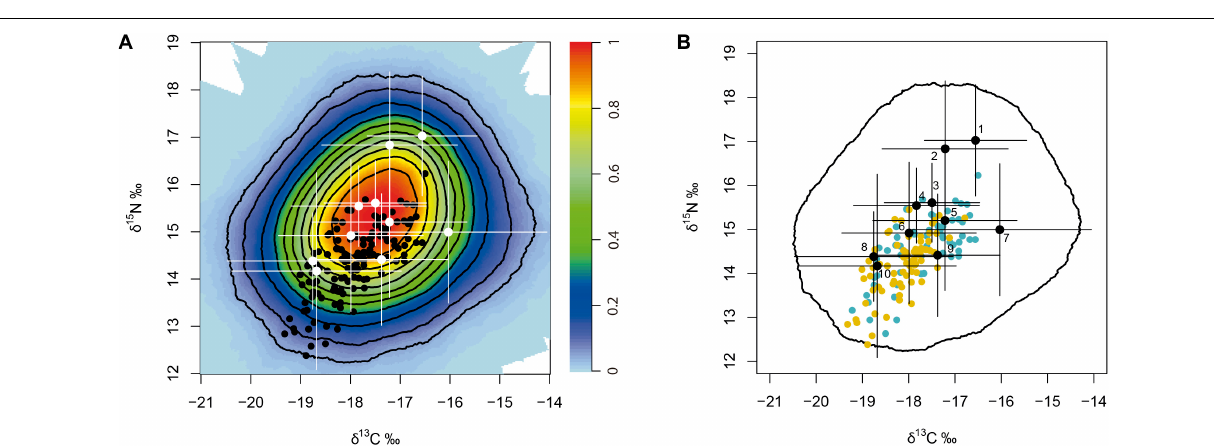
FIGURE 2 | MixPolygon results. (A) Gannets’ isotopic data (black dots) and the potential prey (white dots and bars; mean ± SD). The colour background displays the probability that a consumer’s isotopic signature is explained by the proposed mixing model. Probability contours are printed every 10%. Prey species included are detailed in Table 1 . (B) Gannet data coloured by sex: orange, females; blue, males. Prey data numbered: 1, Trisopterus esmarkii ; 2, Merlangius merlangus ; 3, Merluccius merluccius ; 4, Ammodytes spp.; 5, Chelidonichthys cuculus ; 6, Clupea harengus ; 7, Pleuronectes platessa ; 8, Sprattus sprattus ; 9, Callionymus spp.; 10, Scomber scombrus